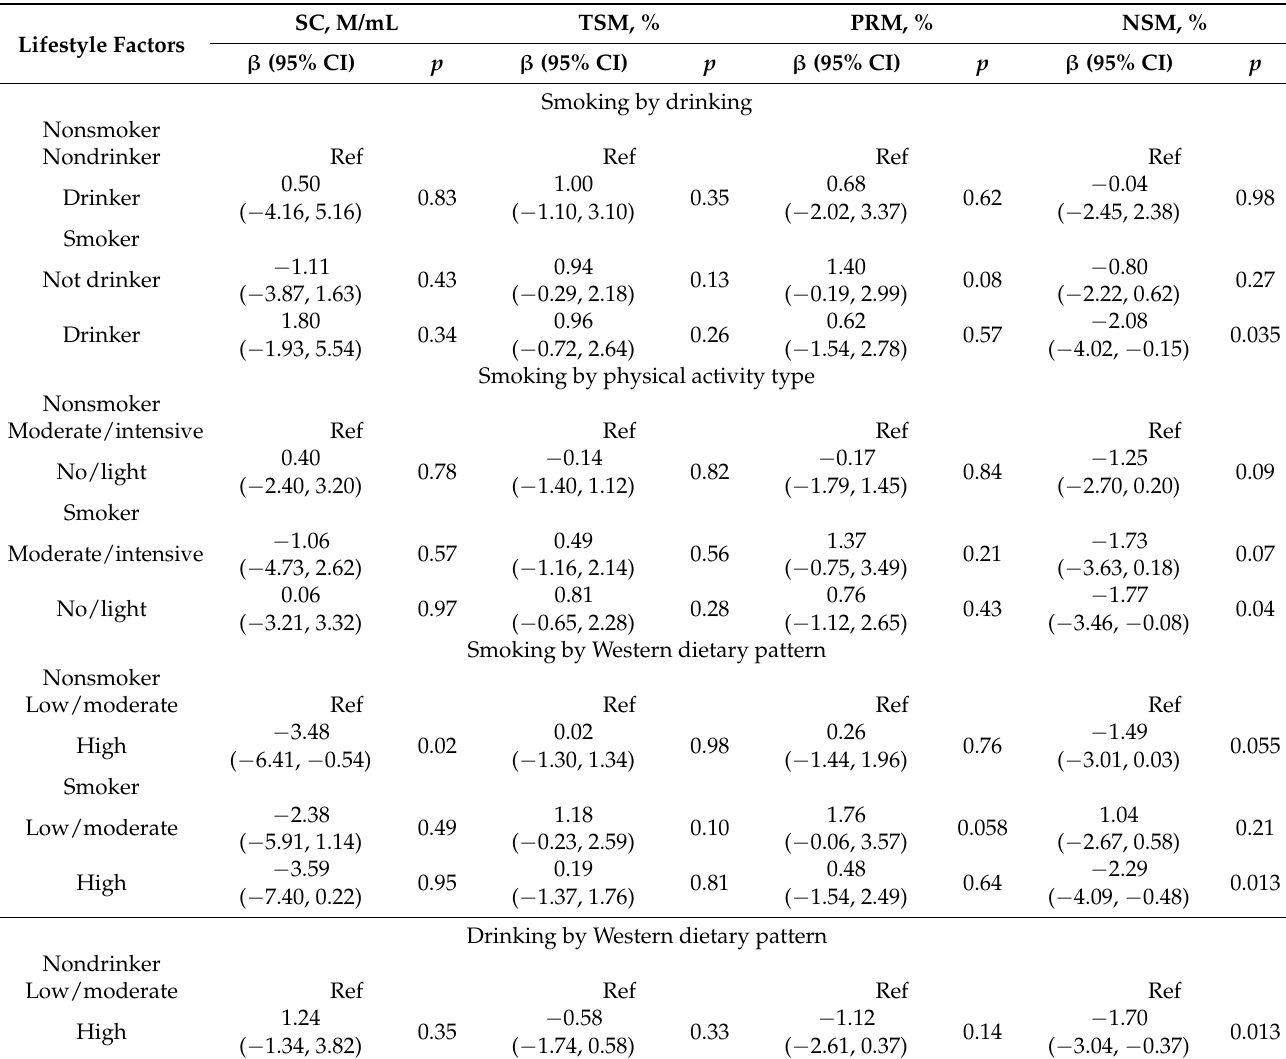
Table 6. Adjusted beta ( β ) coefficient and 95% confidence intervals (CIs) of sperm quality according to interaction of lifestyle